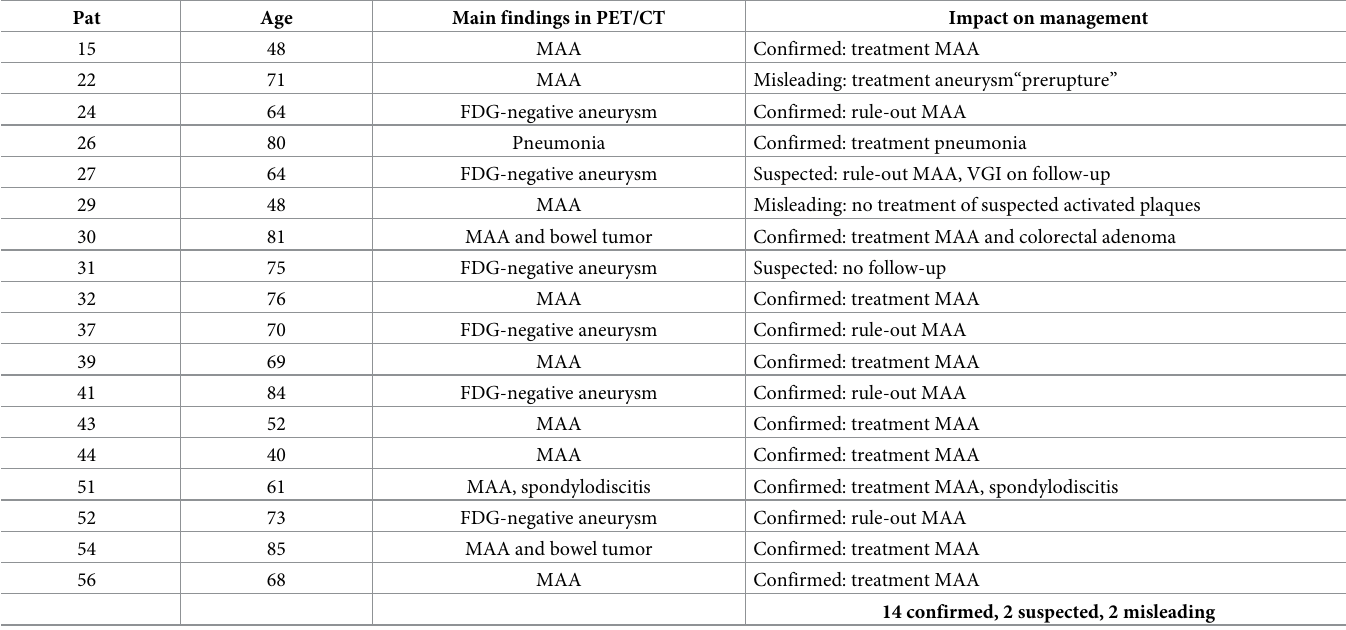
Table 2. Impact on patient management of baseline PET/CT scans with the referral question: Mycotic aortic aneurysm (n = 18). Pat Age